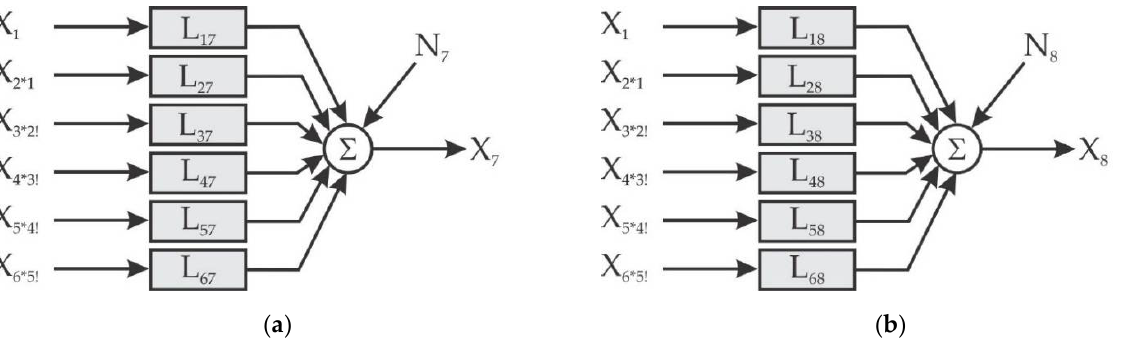
Figure 7. Equivalent multiple input/single output models for conditional spectral analysis: ( a ) equivalent model for the output X 7 ; ( b ) equivalent model for the output X 8 .